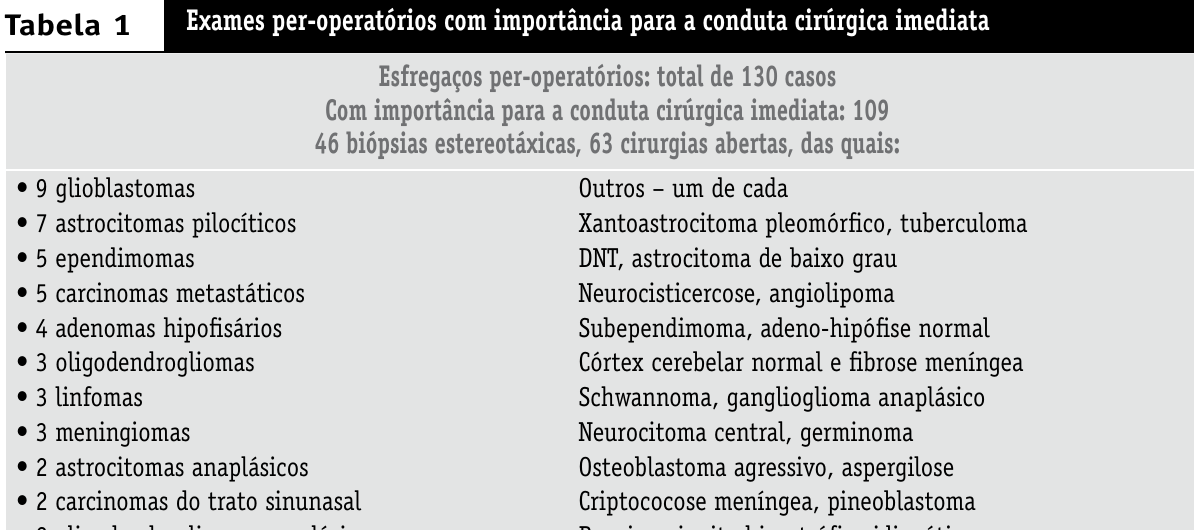
Xantoastrocitoma pleomórfico, tuberculoma DNT, astrocitoma de baixo grau Neurocisticercose, angiolipoma Subependimoma, adeno-hipófise normal Córtex cerebelar normal e fibrose meníngea Schwannoma, ganglioglioma anaplásico Neurocitoma central, germinoma Osteoblastoma agressivo, aspergilose Criptococose meníngea, pineoblastoma Paquimeningite hipertrófica